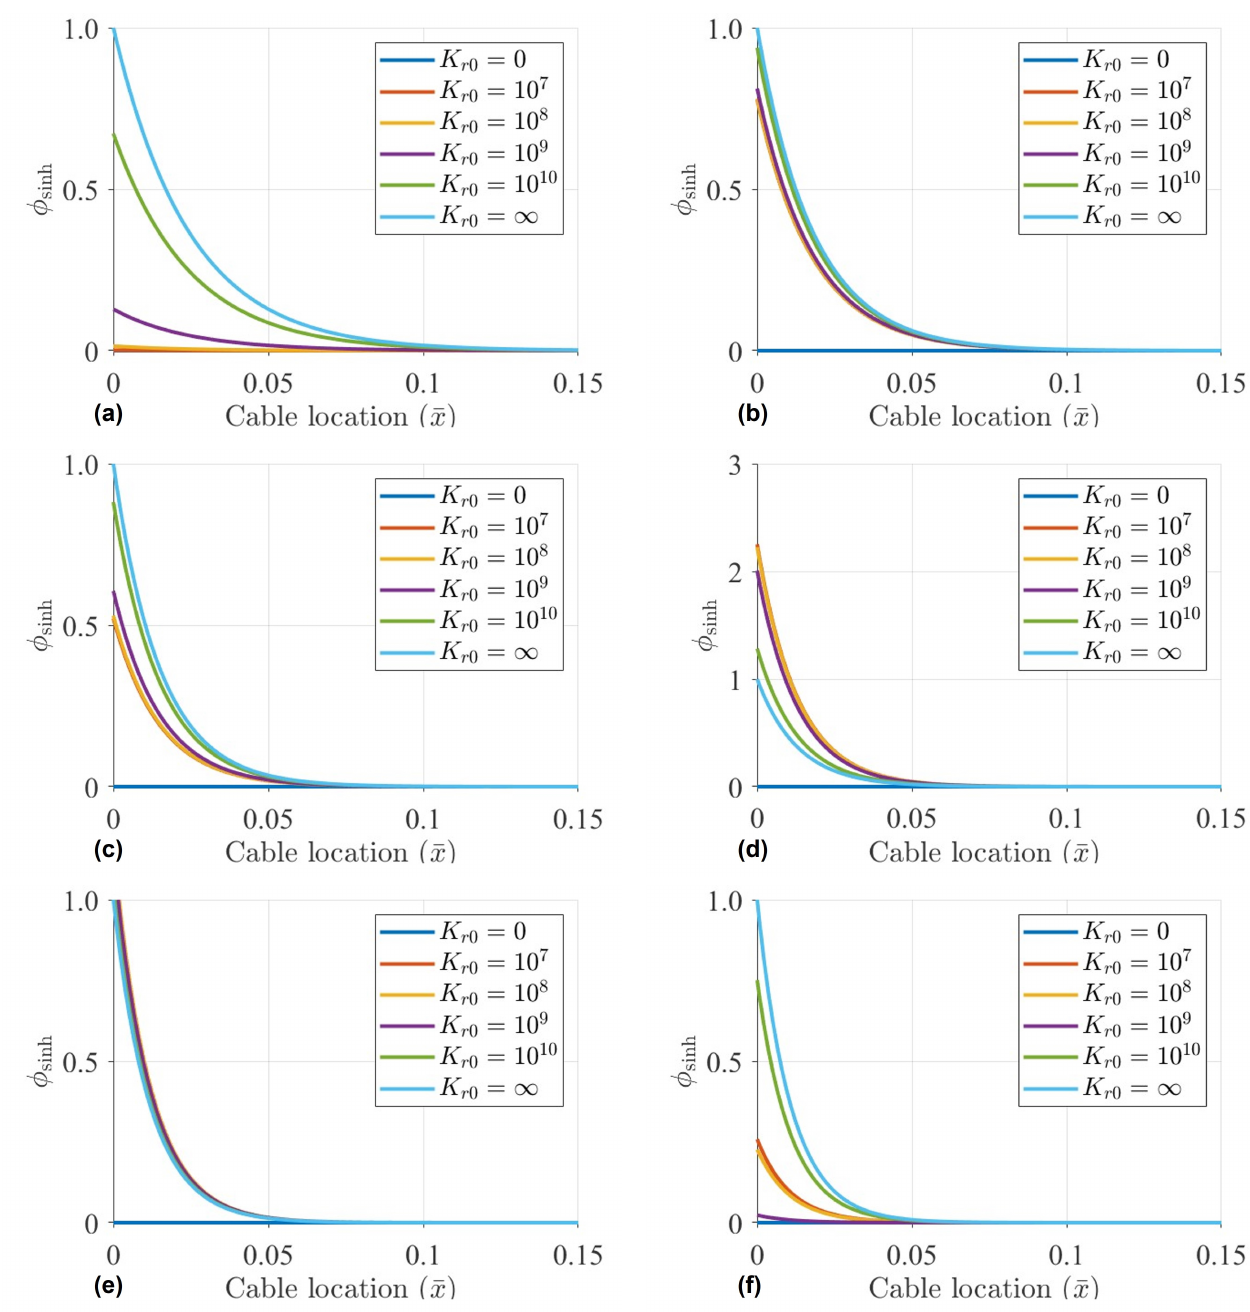
Figure 2. Influence of hyperbolic sine on vibration mode under different rotation coefficients with K l 0 = 10 9 N/m and: ( a ) Mode 1; ( b ) Mode 2; ( c ) Mode 3; ( d ) Mode 4; ( e ) Mode 5; ( f ) Mode